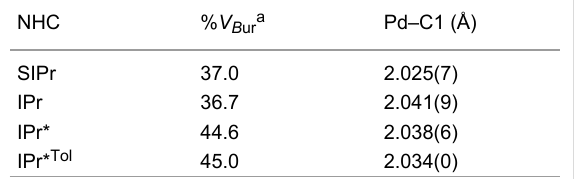
Table 1: Comparison of the % V Bur and d(Pd–C1) in the [Pd(NHC)(cin)Cl] family. NHC